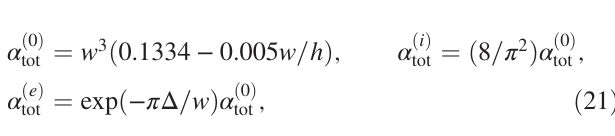
TABLE III. Summary of Leontóvich impedances. High-grade copper with ρ ≈ 5 . 5 × 10 − 10 Ω cm − 1 at 20 K. OCMF with 1 mm pores and 0.1 mm ligaments. Slots in a perfectly conducting wall as in Fig. 5, with w ¼ Δ ¼ 1 . 5 mm, h ¼ 10 w , and s Solid copper patch OCMF patch OCMF roughness Slotted patch (perfect